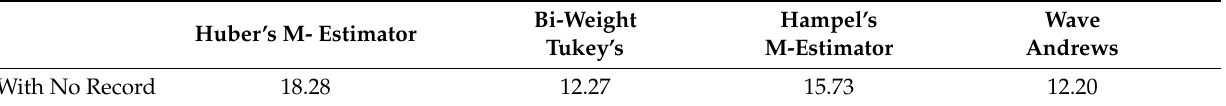
Table 3. M estimators for the criterion of Volume of